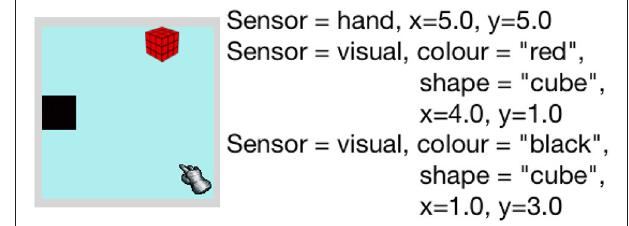
FIGURE 9 | Left : Simulator environment containing end-effector, hole and an object. Right : description of the sensory information of the environment.